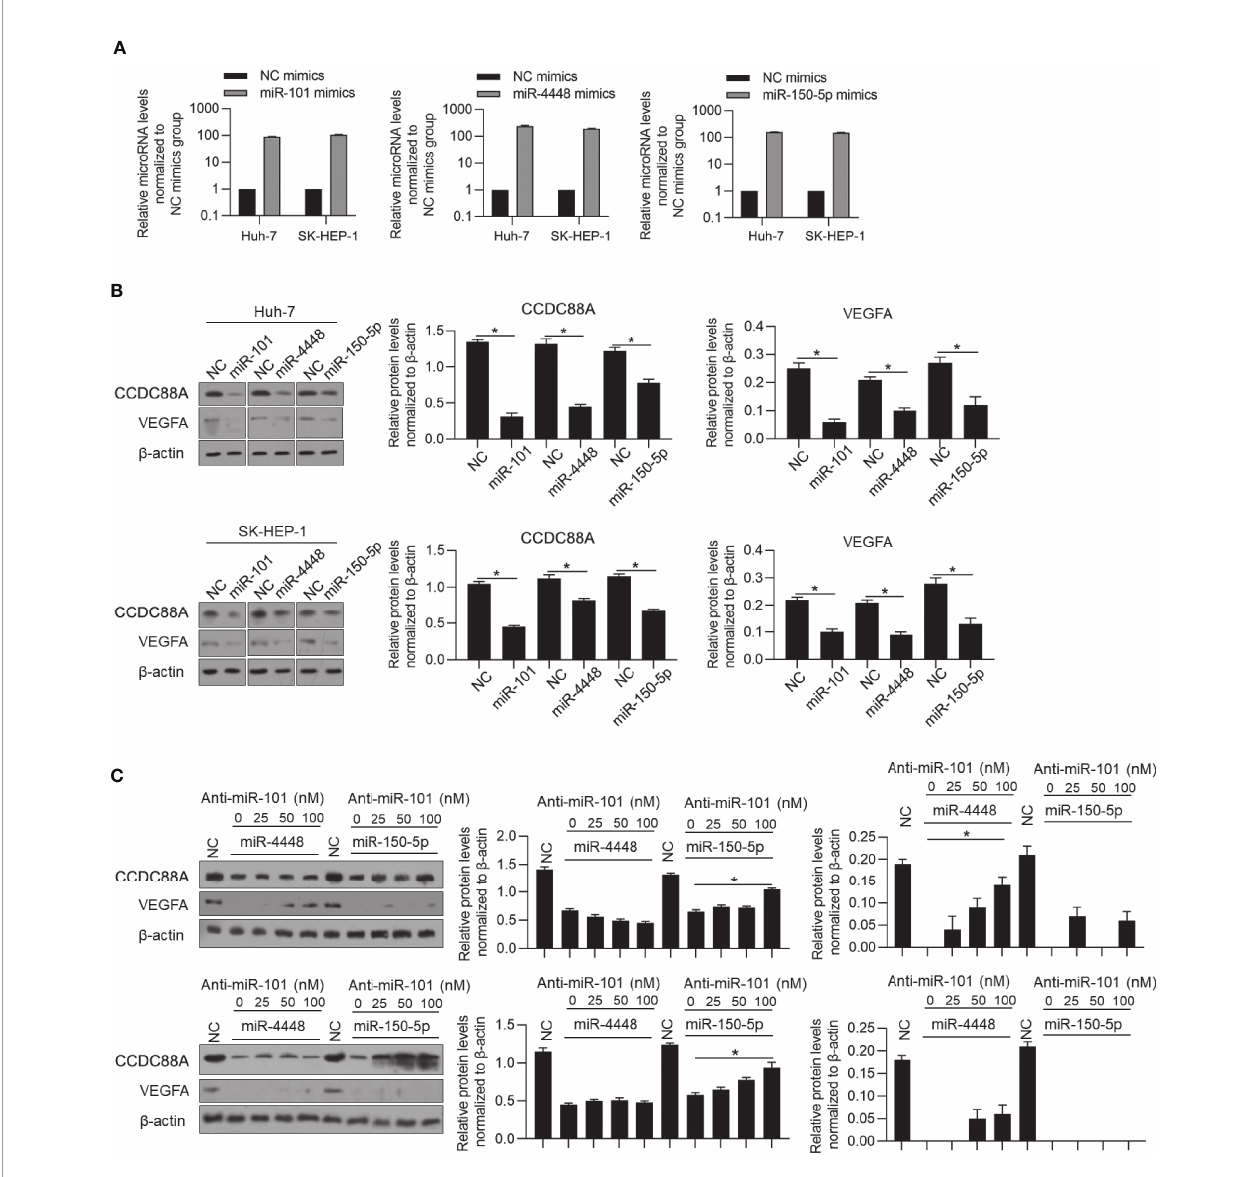
FIGURE 7 | CCDC88A may protect VEGFA from miR-101 posttranscriptionally. (A) After transfection of miR-101, miR-4448 or miR-150-5p mimics for 48 h, respectively, miR-101, miR-4448, or miR-150-5p RNA levels were detected by performing RT-qPCR. (B) After transfection of miR-101, miR-4448 or miR-150-5p mimics for 48 h, respectively, protein levels of CCDC88A and VEGFA were detected by performing western blot. *P < 0.05, vs. NC group. (C) miR-4448 or miR- 150-5p was co-transfected into Huh-7 and SK-HEP-1 cells together with different concentrations of anti-miR-101 antagonist (25, 50, or 100 nM), and protein levels of CCDC88A and VEGFA were detected by performing western blot. *P < 0.05, vs. NC